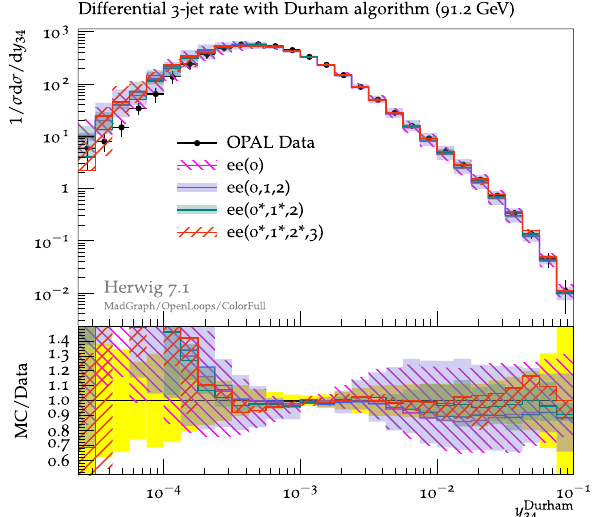
Fig. 16 Comparison to OPAL data from [62]. The scale uncertainties of the LO+PS ee ( 0 ) are not reduced by merging with higher multiplici- ties. Inserting NLO corrections to the first and second emission reduces the bands from scale variations significantly. The observable measures the transition from a three- to a four-jet configuration and is therefore sensitive to the second emission. The NLO corrections to the second emission included in ee ( 0 ∗ , 1 ∗ , 2 ∗ , 3 ) reduce the uncertainty band even more